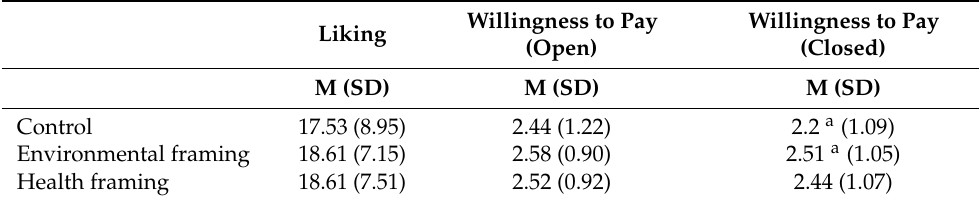
Table 2. Mean scores across messaging conditions for the three dependent variables in Study 2.